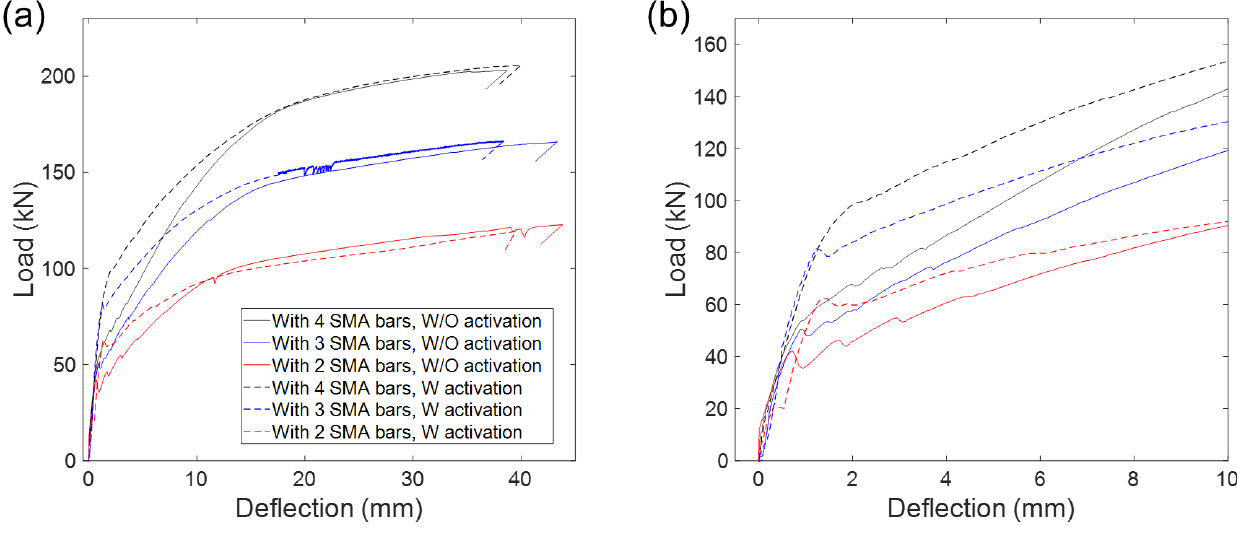
Figure 11. Experimental bending load-deflection curves of RC beams with various numbers of Fe-SMA bars, with and without Fe-SMA activation. ( a ) Overall load-deflection curves up to fracture and ( b ) enlarged view in deflection range of 0 – 10 mm.